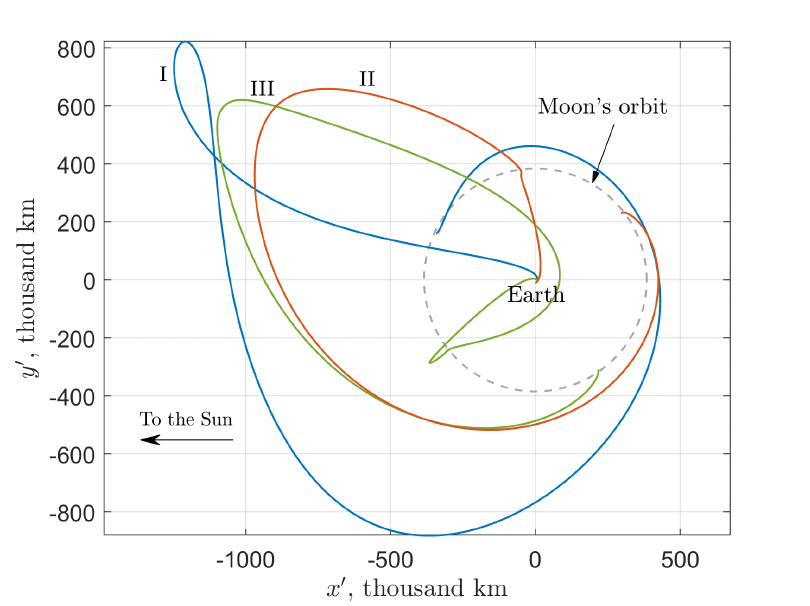
Figure 12. Three types of SALT trajectories: (I) without any intermediate lunar flyby, (II) with a direct lunar flyby, (III) with a retrograde lunar flyby. The Moon’s orbit is marked by the dashed gray line.